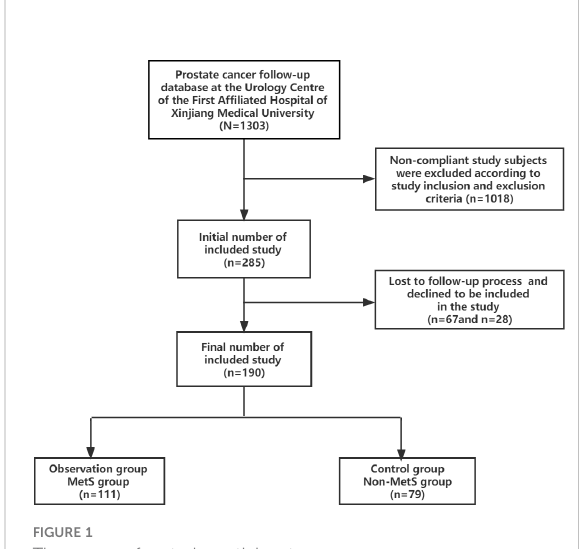
FIGURE 1 The process for study